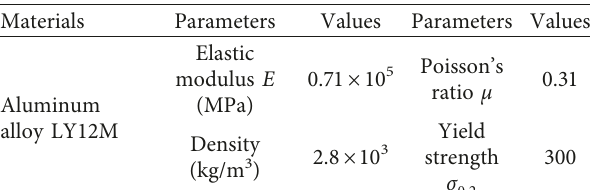
Table 1: Mechanical properties of joint materials.